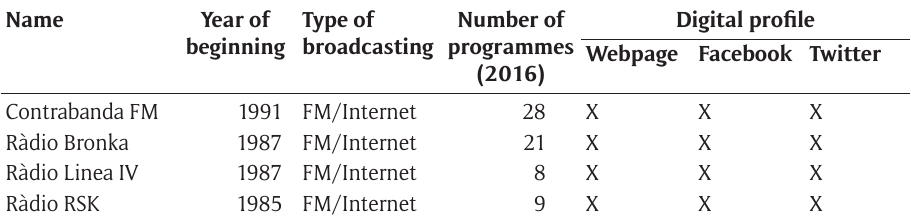
Table 3: Contrabanda FM, Ràdio Bronka, Ràdio Linea IV and Ràdio RSK description (2016).